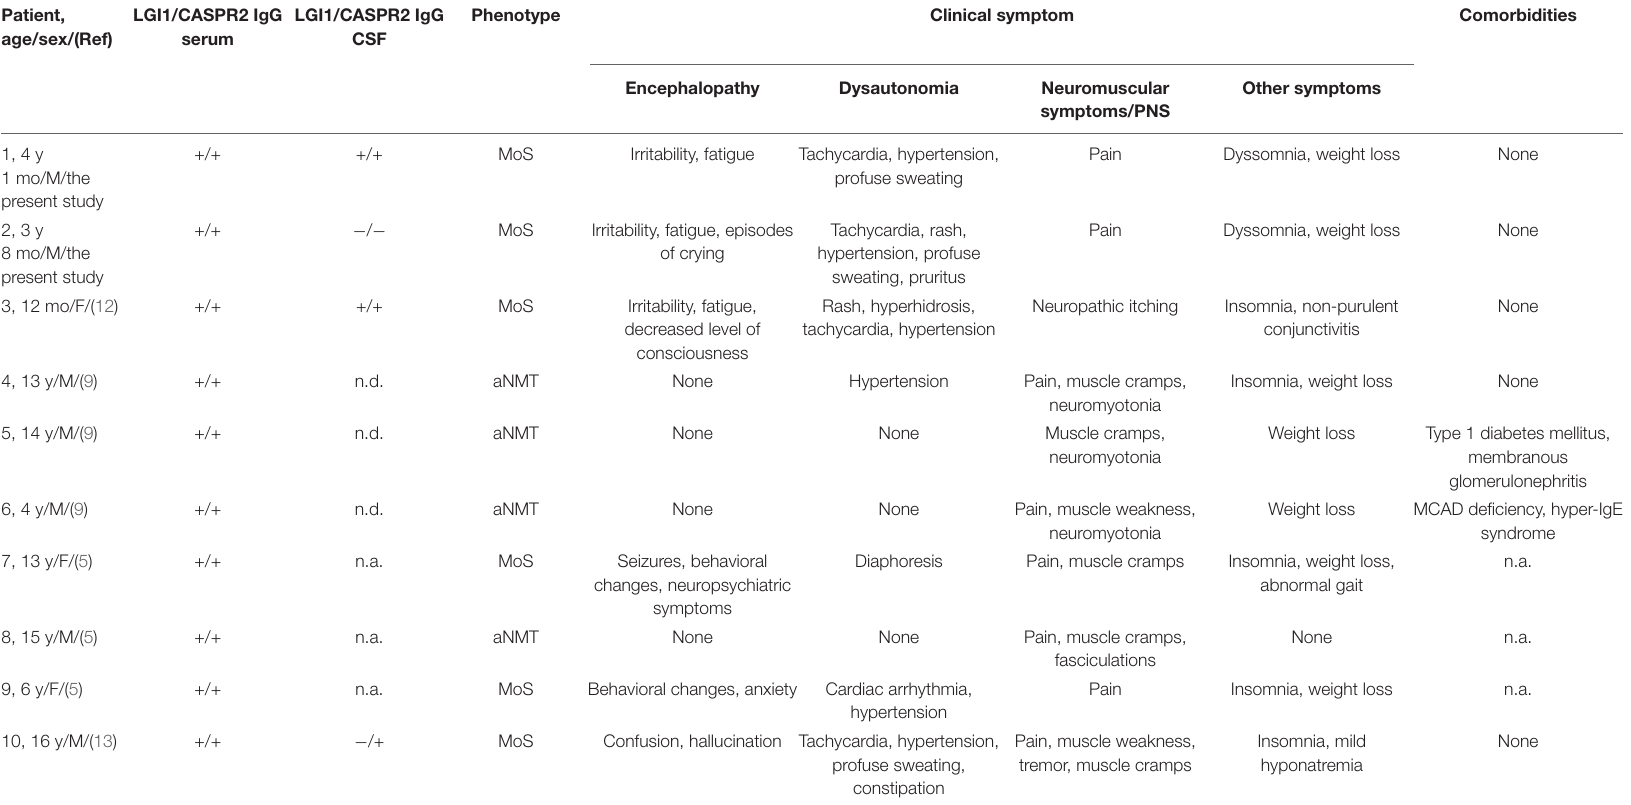
TABLE 1 | Clinical characteristics of pediatric patients associated with double antibody-positive (LGI1 and CASPR2). Patient, LGI1/CASPR2 IgG age/sex/(Ref)